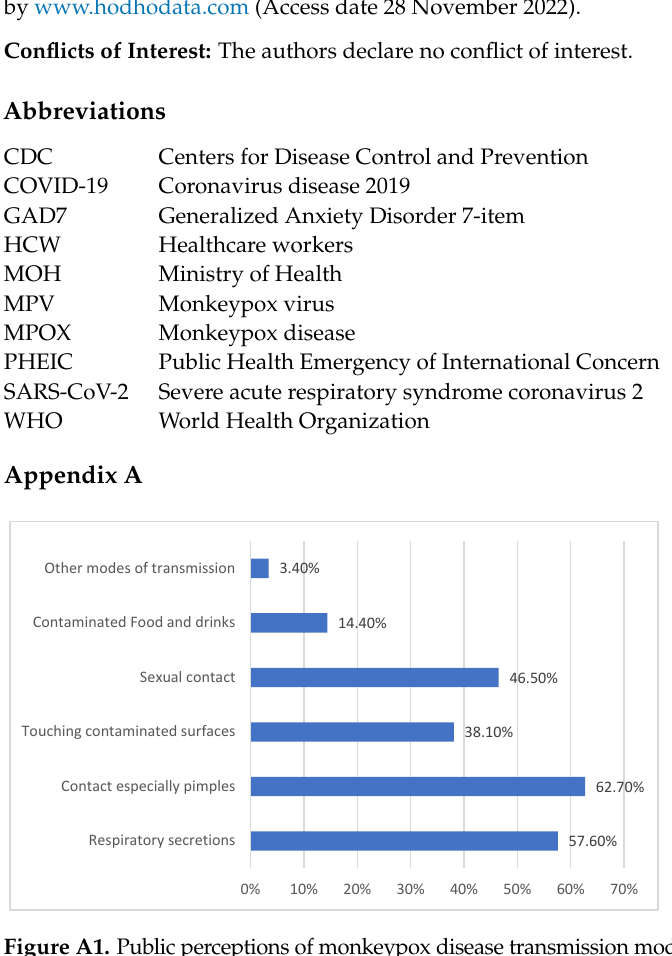
Figure A2. Public sources of information about monkeypox disease. (KSA, 27 May to 5 June 2022.)